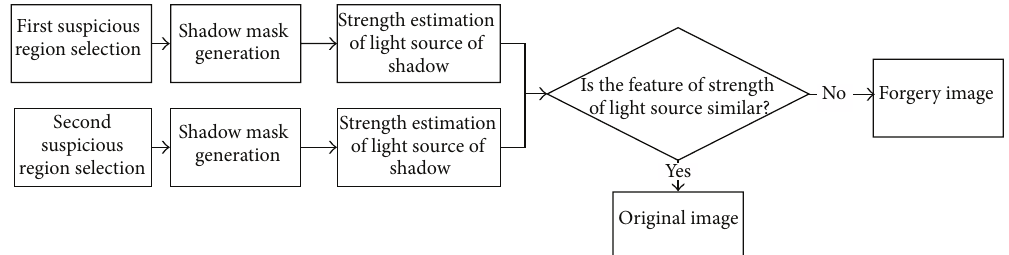
Figure 4: Image forgery detection method based on strength consistency of light source of